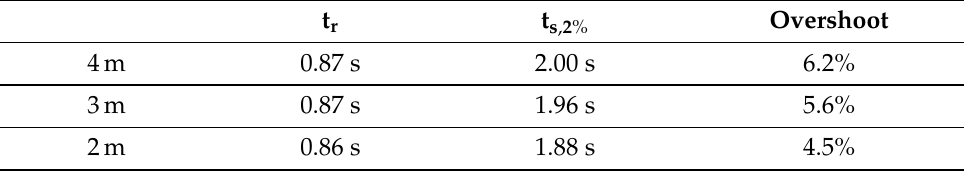
Table 9. Height overshoot for different altitudes using adaptive LQR,